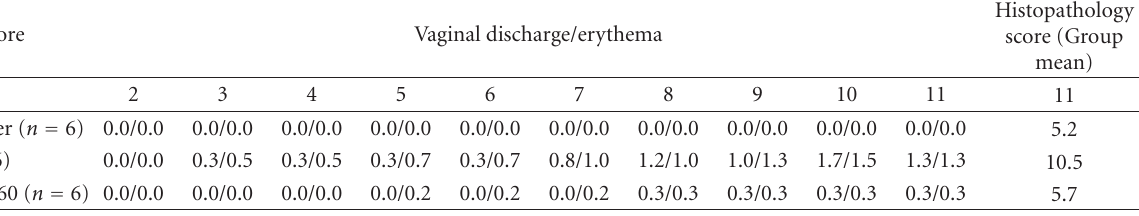
Table 2: Individual vaginal irritation and histopathology scores. Histopathology scores include evaluation of epithelium, leukocytes infil- tration, vascular congestion, and edema.